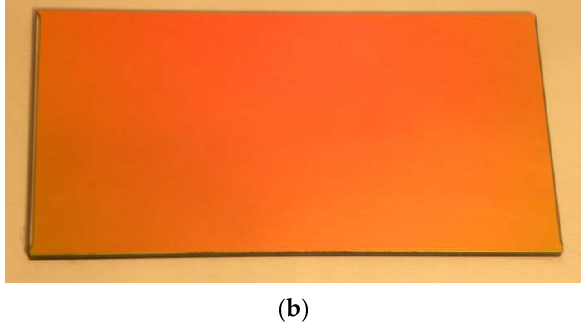
Figure 3. The general view of the optic filters with interference Si–SiO coating, formed on a sapphire substrate: ( a )—a round sample with a diameter of 30 mm; and ( b )—a rectangular sample with dimensions of 150 × 80 mm.